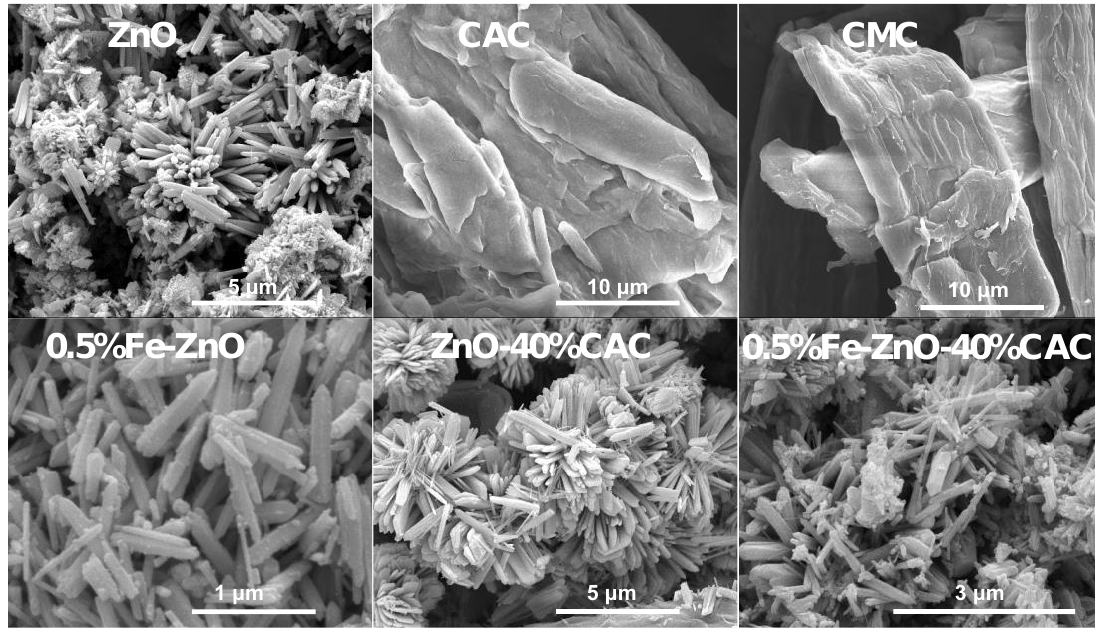
Figure 3. SEM images of selected materials.